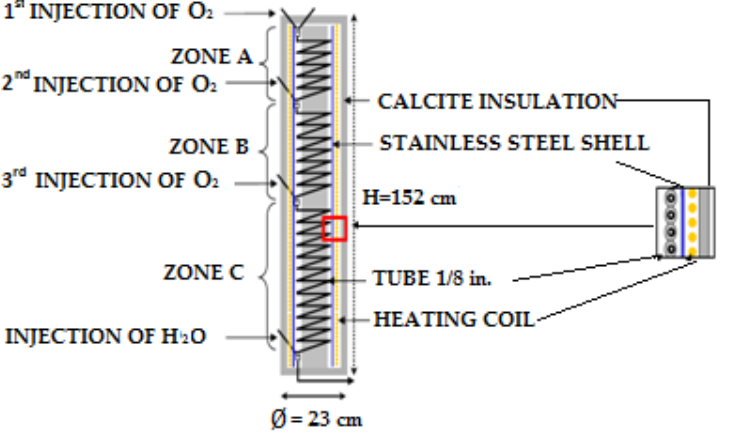
Figure 12. Vertical multi-injection reactor [87].